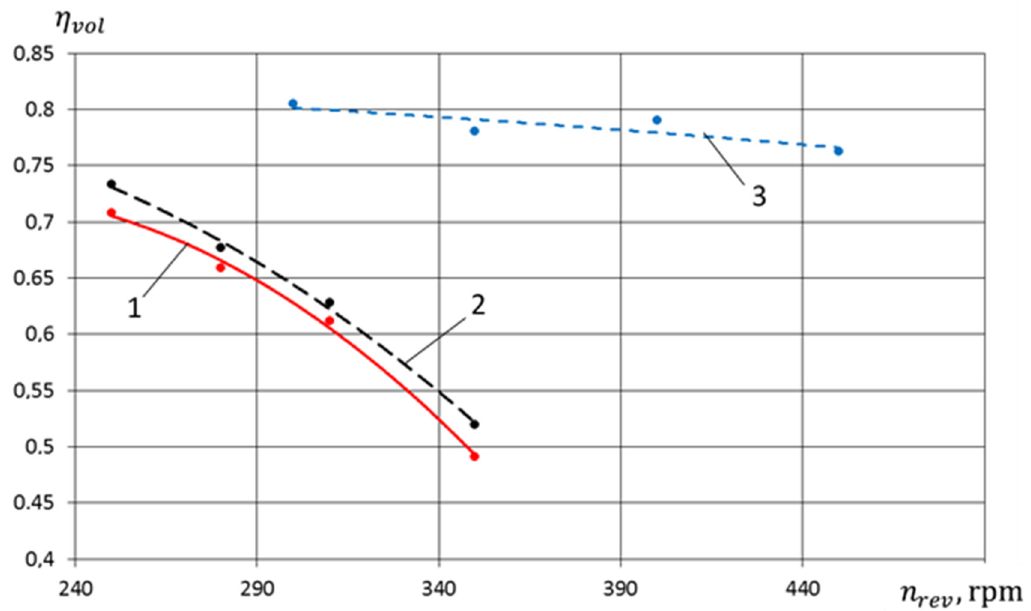
Figure 39. Dependence of volumetric efficiency the pump section from the angular velocity of the crankshaft (1—PHPM with step-type gap seals; 2—PHPM with a smooth gap seal; 3—Crosshead-free PHPM).